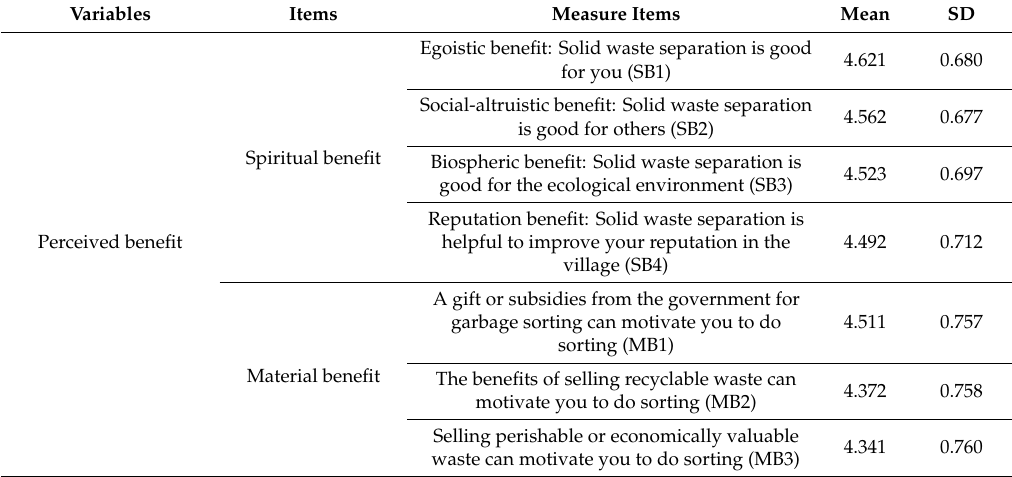
Table 2. Definition and descriptive statistics of dependent variables (N =